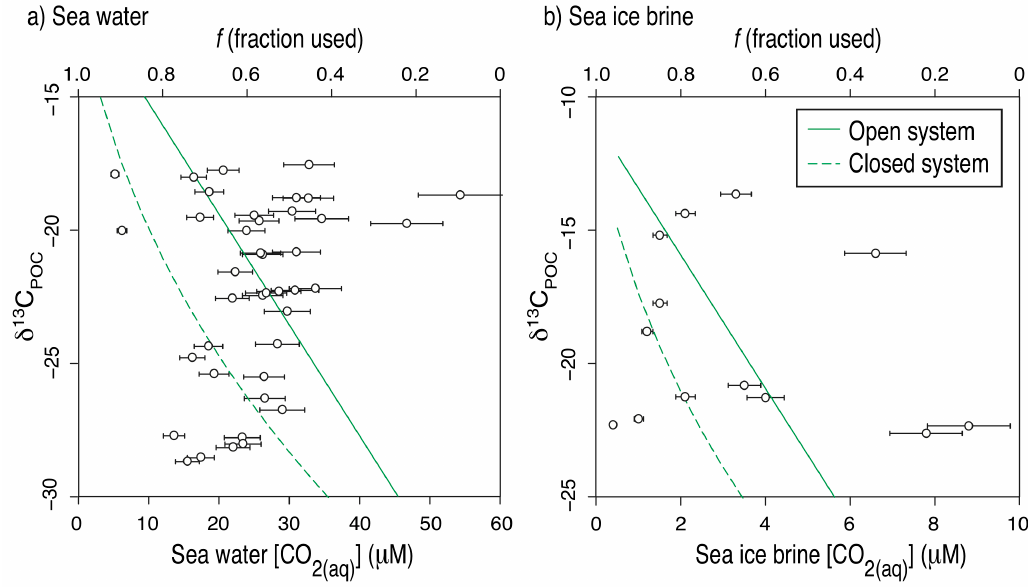
Fig. 8. δ 13 C POC versus [CO 2 (aq)] in (a) surface sea water and (b) sea ice brine. Open circles are data points observed. X-axis error bars depict 11% maximum error associated with [CO 2 (aq)] calculation using the CO2SYS programme. Solid lines show the modelled relationships between δ 13 C POC and [CO 2 (aq)] under open system dynamics, where ε p = 25‰. Dashed lines show modelled relationships under closed system dynamics, assuming an accumulated product and ε p = 25‰. f is fraction used compared to maximum values for CO 2 (aq). A full explanation of equations used is in the